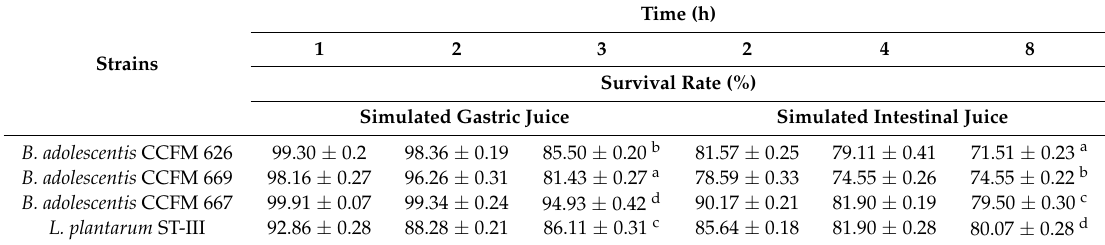
Table 1. Tolerance of Bifidobacterium adolescentis strains to simulated gastric and small intestinal juices. Time (h) 1 2 Strains